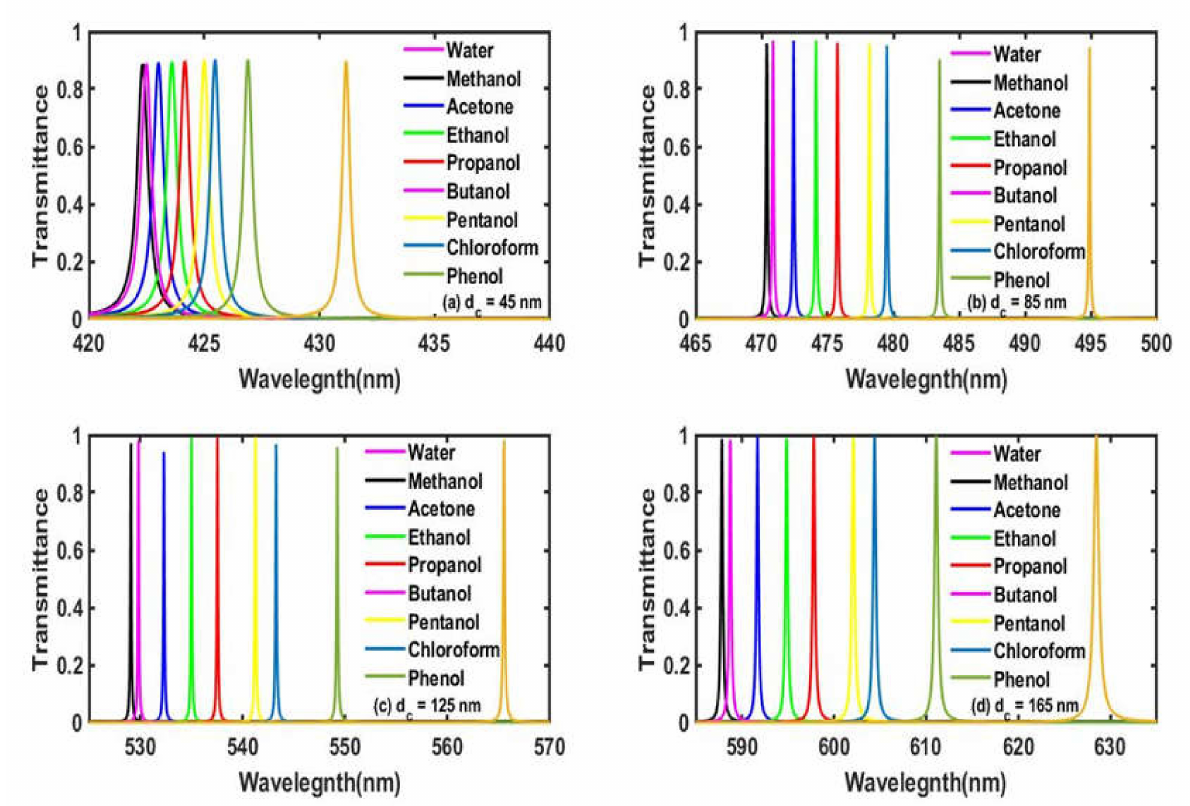
Figure 4. The transmittance spectra of the proposed bio-alcohol sensor loaded separately with water samples containing methanol, acetone, ethanol, propanol, butanol, pentanol, chloroform and phenol, each of a concentration of 30% with respect to pure water samples at a normal incidence corresponding to different cavity thicknesses ( a ) d c = 65 nm, ( b ) d c = 85 nm, ( c ) d c = 125 nm and ( d ) d c = 165